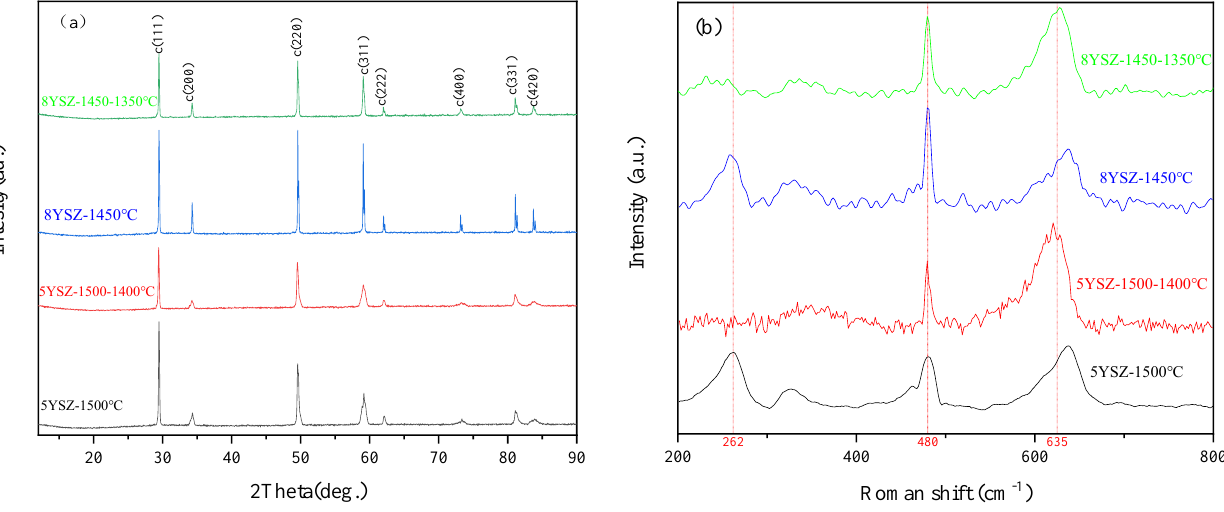
Figure 5. ( a ) XRD patterns; ( b ) Raman patterns of four YSZ samples under 2 holding time. Table 2. The phase composition, cell parameters, and cell volume of four ceramics at different sintering conditions.